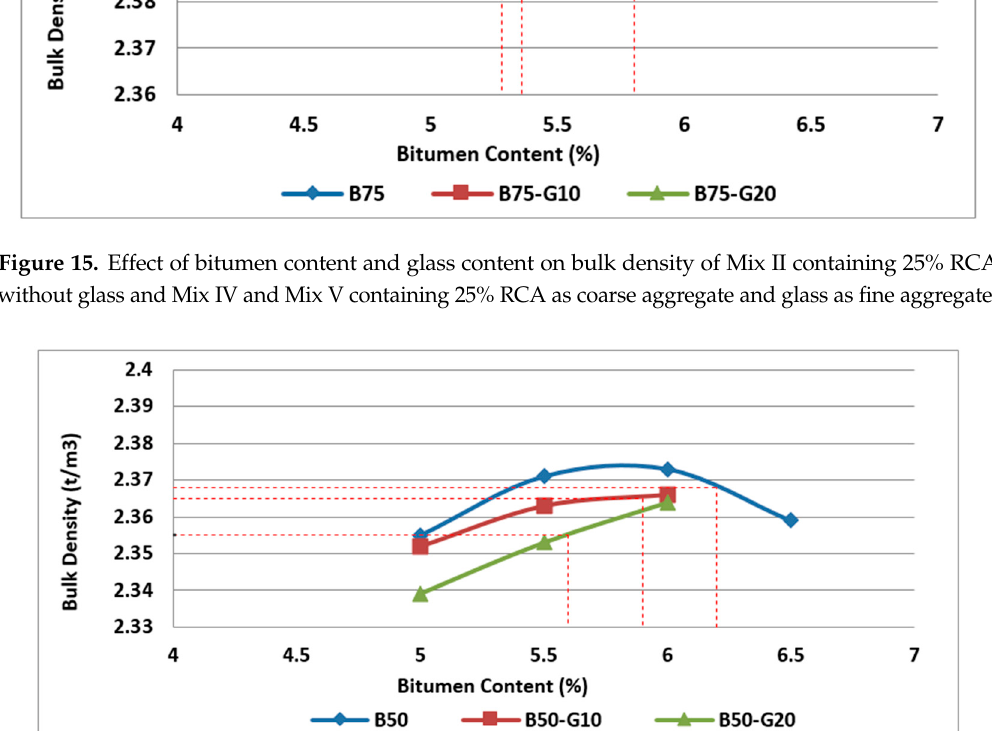
Figure 15. Effect of bitumen content and glass content on bulk density of Mix II containing 25% RCA without glass and Mix IV and Mix V containing 25% RCA as coarse aggregate and glass as fine aggregate.